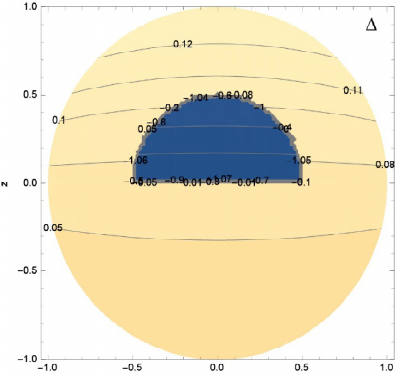
Fig. 4. Map of elastic dilatation caused by the hemi- spherical inclusion in the sphere. The dilatation val- ues are given in units of  *. The map coordinates are normalized to the sphere radius a . Calculations are made for the material with  =0.3.